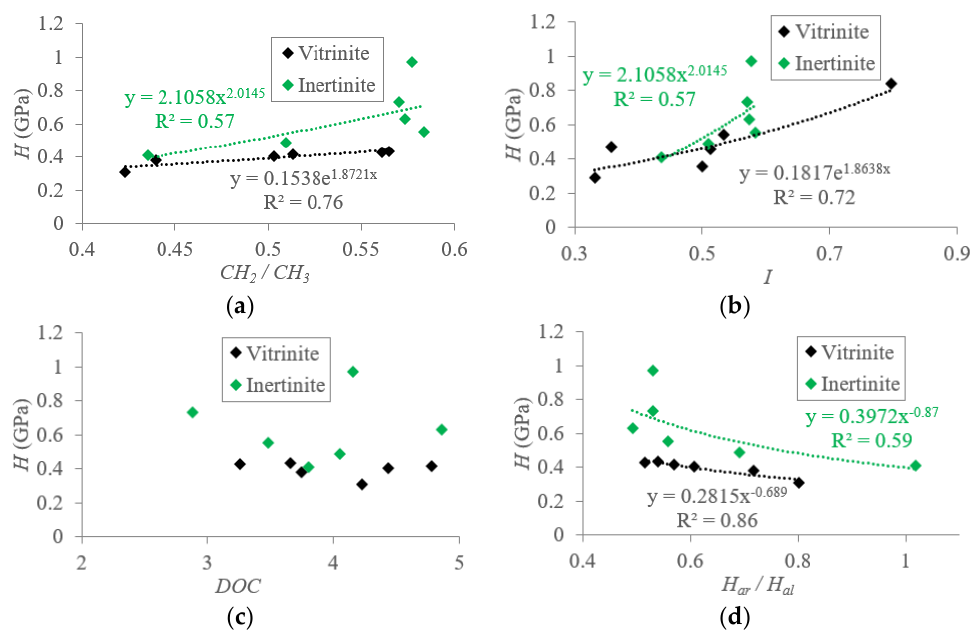
Figure 14. Relationship between FTIR parameters (( a – d ) are the CH 2 / CH 3 , I , DOC , and H ar / H al , respectively) and H. (Note: Here, H is the mean value for each sample).